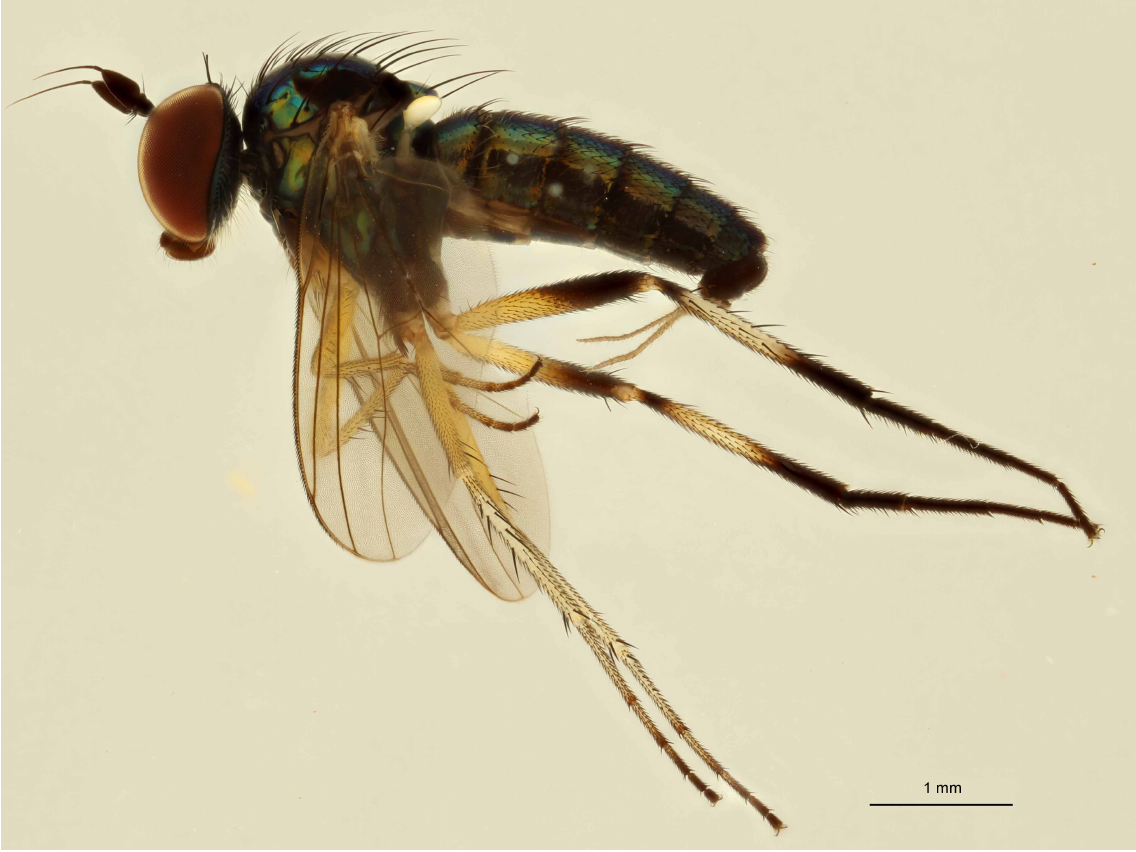
Fig. 5. Rhaphium canniccii sp. nov., holotype, ♂, habitus (RBINS). Scale bar: 1 mm. (Photo credit Ms